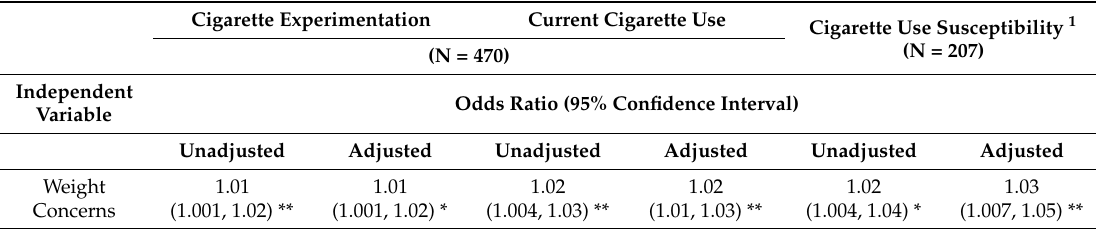
Table 2. Associations of weight concerns with cigarette smoking status and cigarette smoking